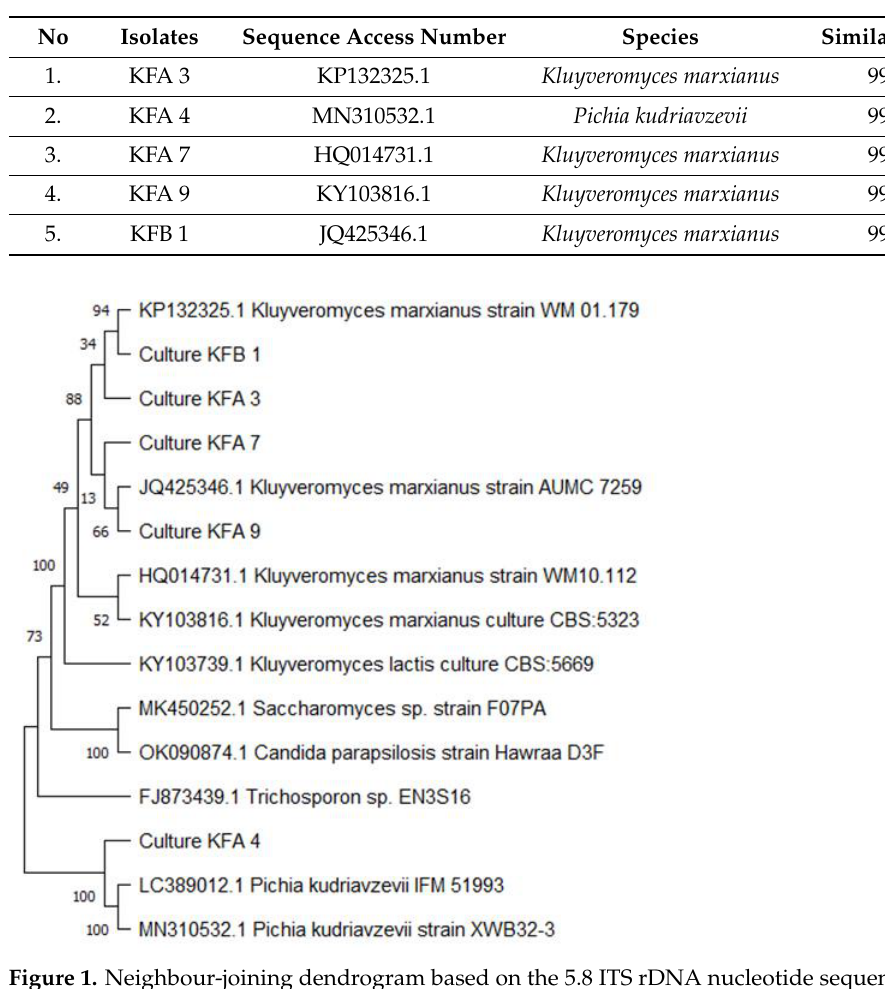
Figure 1. Neighbour-joining dendrogram based on the 5.8 ITS rDNA nucleotide sequences of five yeast isolates with relevant corresponding sequences in the GeneBank database. yeast isolates with relevant corresponding sequences in the GeneBank